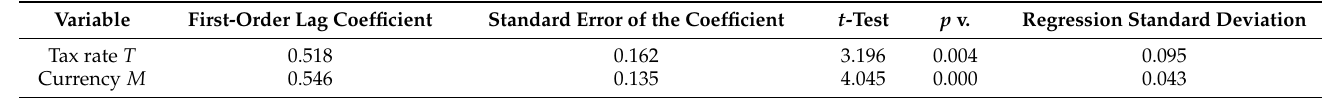
Table 1. Regression results.